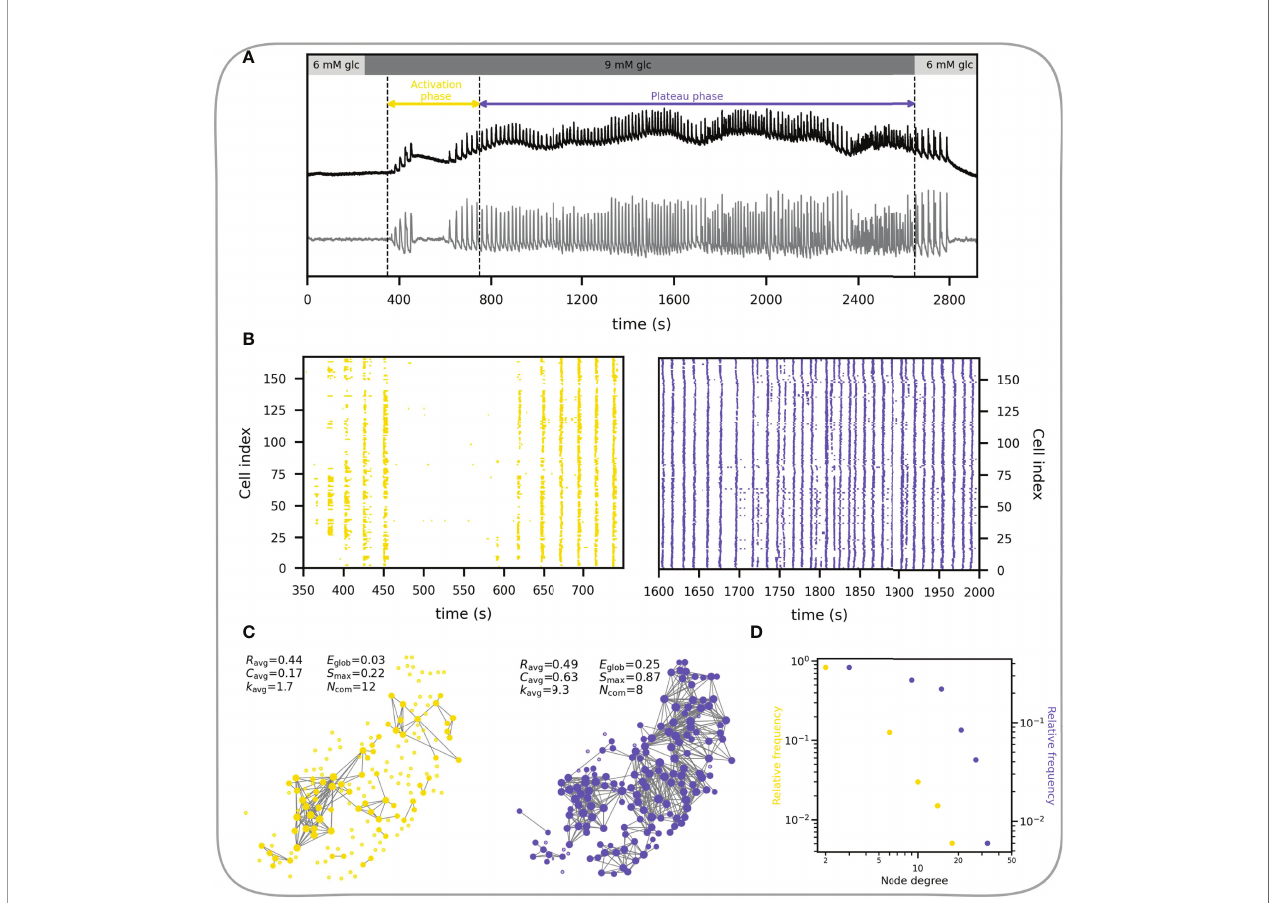
FIGURE 6 | Characteristics of the functional beta cell network in response to stimulation. (A) Average Ca 2+ signal of an islet subjected to a 6-9-6 mM glucose stimulation protocol. Black line represents the unprocessed Ca 2+ signal and the gray line represents the extracted fast component of cellular activity. Colored horizontal arrows indicate the selected activation and plateau phases for further analysis. (B) Raster plots showing the binarized fast component of beta cell activity for the activation (left) and plateau (right) phase as indicated in panel (A) . (C) Functional beta cell networks constructed for both phases (left, activation phase; right, plateau phase) based on fast signal components of all cells with a correlation coef fi cient threshold for connectivity R th = 0.8. The following parameters for each functional network are provided: average correlation coef fi cient ( R avg ), average clustering coef fi cient ( C avg ), average network node degree ( k avg ), global ef fi ciency ( E glob ), largest connected component ( S max ) and the number of communities ( N com ). (D) Node degree distributions for the networks extracted in the activation (yellow dots) and plateau phase (blue